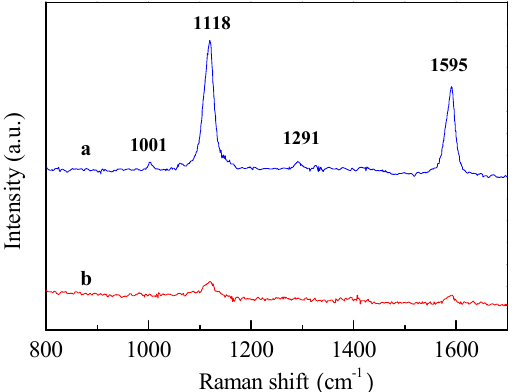
Figure 10. Raman spectra of used Cu 2 O samples after a 24-h reaction. ( a ) Cu 2 O-NO 3 ; ( b ) Cu 2 O-Cl(2). Before characterization, the catalysts were washed with deionized water and then dried in a vacuum for 12 h at 30 °C.